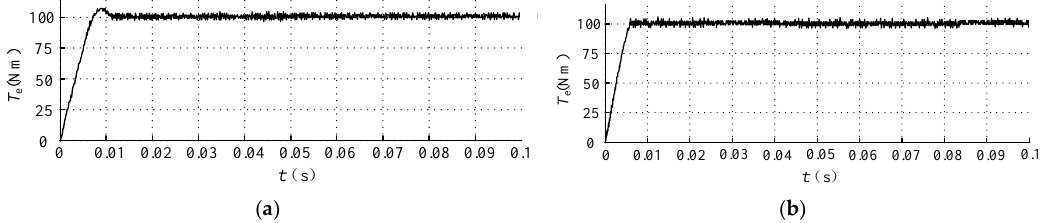
Figure 10. ( a ) Torque tracking waveform of the PI controller-based drive control system; ( b ) Torque tracking waveform of the sliding mode controller-based drive control system.